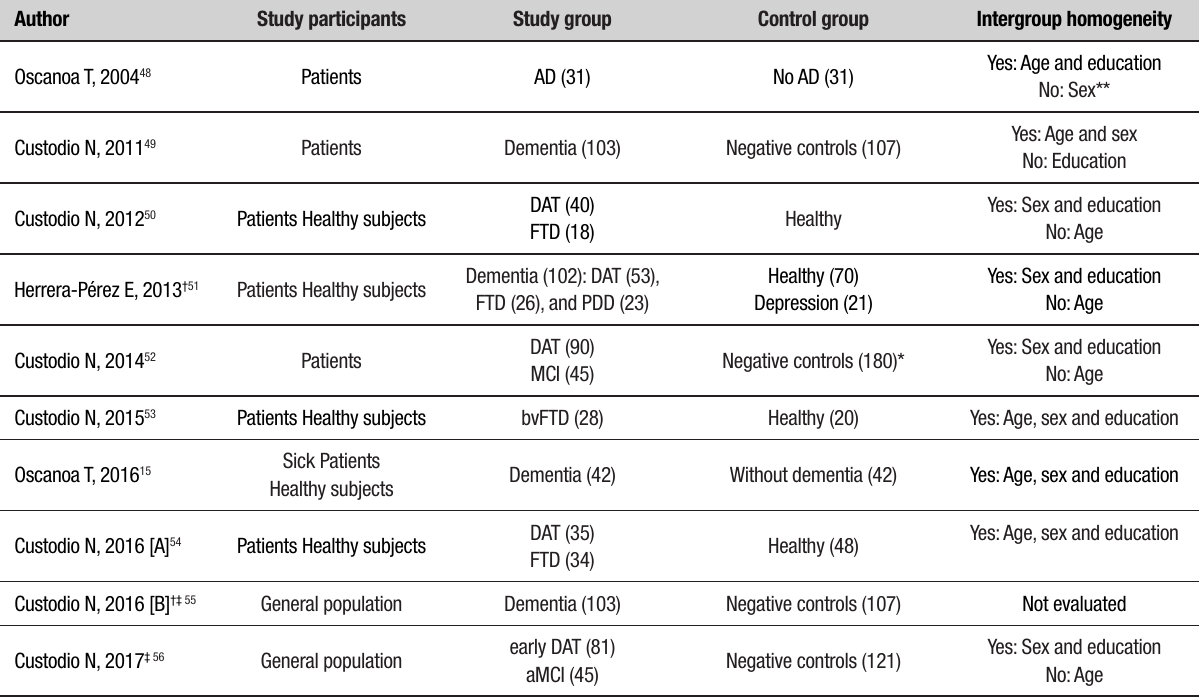
Table 1. General study